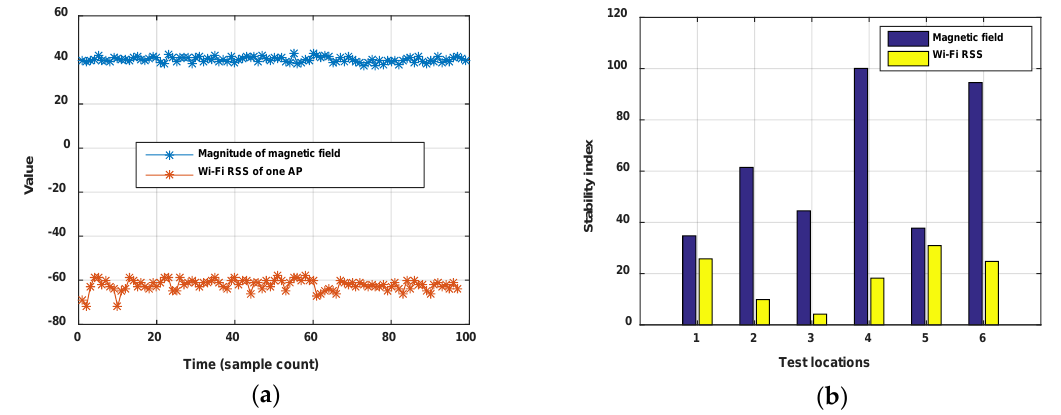
Figure 1. Comparison of stability between Wi-Fi and magnetic field at a simple location: ( a ) Time sequences for magnitude of magnetic field and Wi-Fi RSS of one AP measured on location 1 at the same time; ( b ) Stability index comparison between Wi-Fi and magnetic field for six test locations.